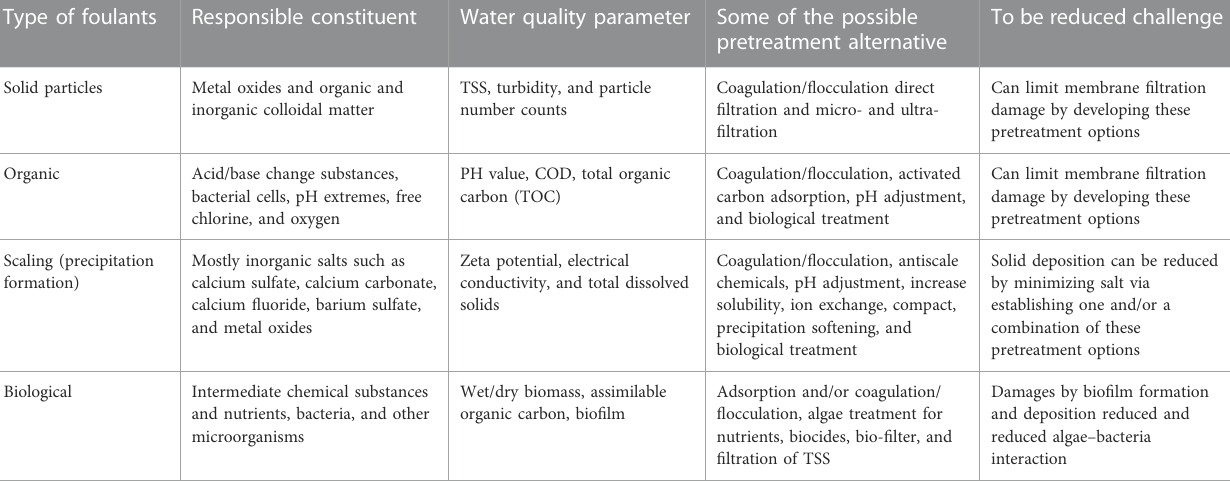
TABLE 4 Major foulants and ef fl uent constituents with their appropriate pretreatment options and evaluation. Type of